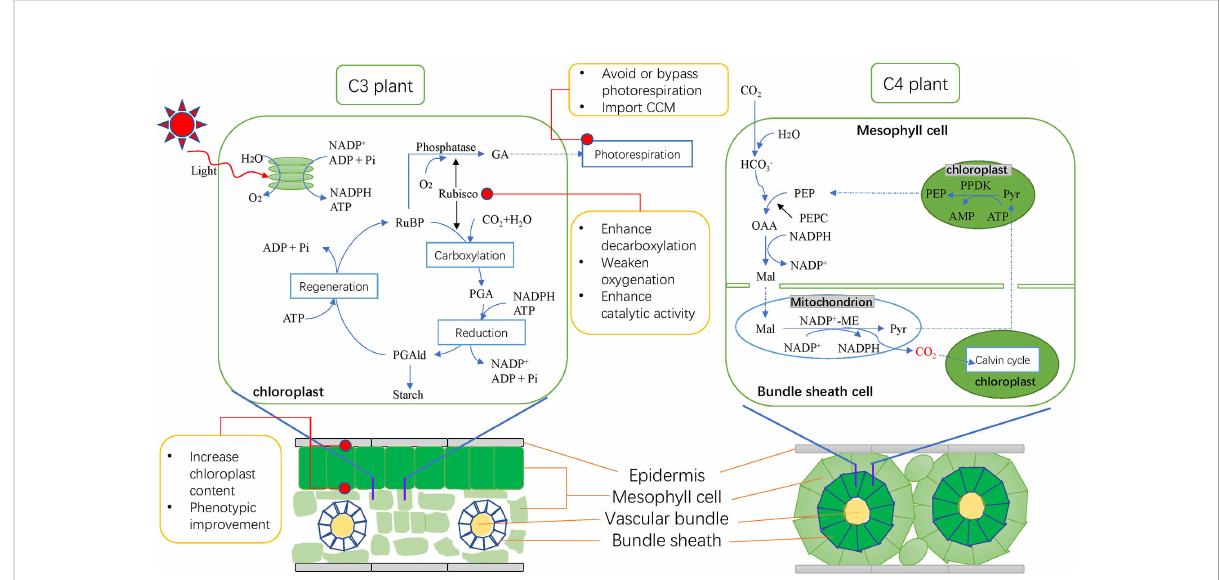
FIGURE 1 Photosynthetic pathway, leaf structure of C3 and C4 plants and main improvement methods for C3 plants at present. C3 plants on the left and C4 plants on the right. Blue solid line represents the photosynthetic reaction; blue dotted line represents the transport of substances; black line represents the catalysis of the enzyme; red dots represent major improvement objectives. RuBP, ribulose-1,5-bisphosphate; Rubisco, RuBP carboxylase/oxygenase; PGA, 3-phosphoglycerate; PGAld, 3-phosphoglyceraldehyde; GA, glycollic acid; PEP, Phosphoenolpyruvate; PEPC, Phosphoenolpyruvate carboxylase; OAA, oxaloacetic acid; Mal, malic acid; Pyr, pyruvic acid; NADP-ME, NADP-malic enzyme; PPDK, pyruvate phosphate dikinase; CCM, carbon concentration